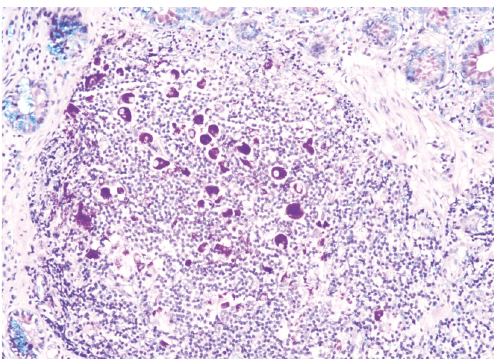
Figure 1: Biopsies of the ileal mucosa appearing normal structurally and cellularly. The submucosa is occupied by a Peyer’s patch (asterisk). Hematoxylin and eosin original magnification, 40x.